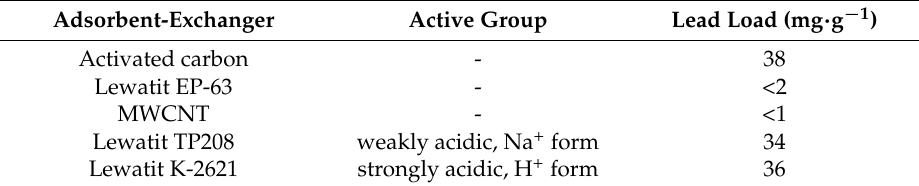
Table 9. Pb 2+ uptake by different adsorbents/ion exchangers.